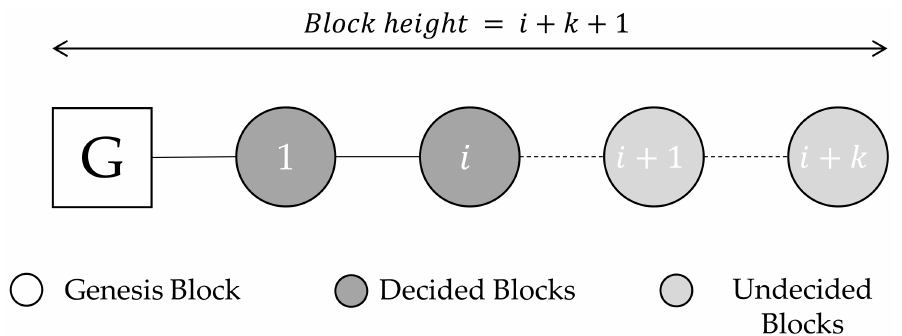
Figure 7. Testnet Mining